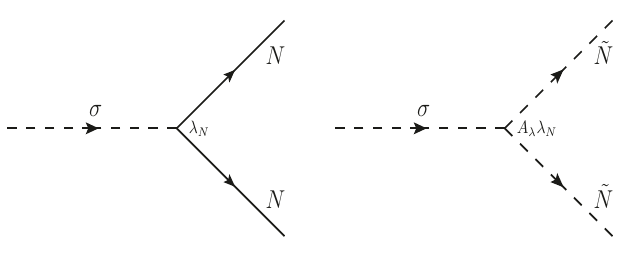
Figure 3 . Decay diagrams of a singlet scalar (cid:27)